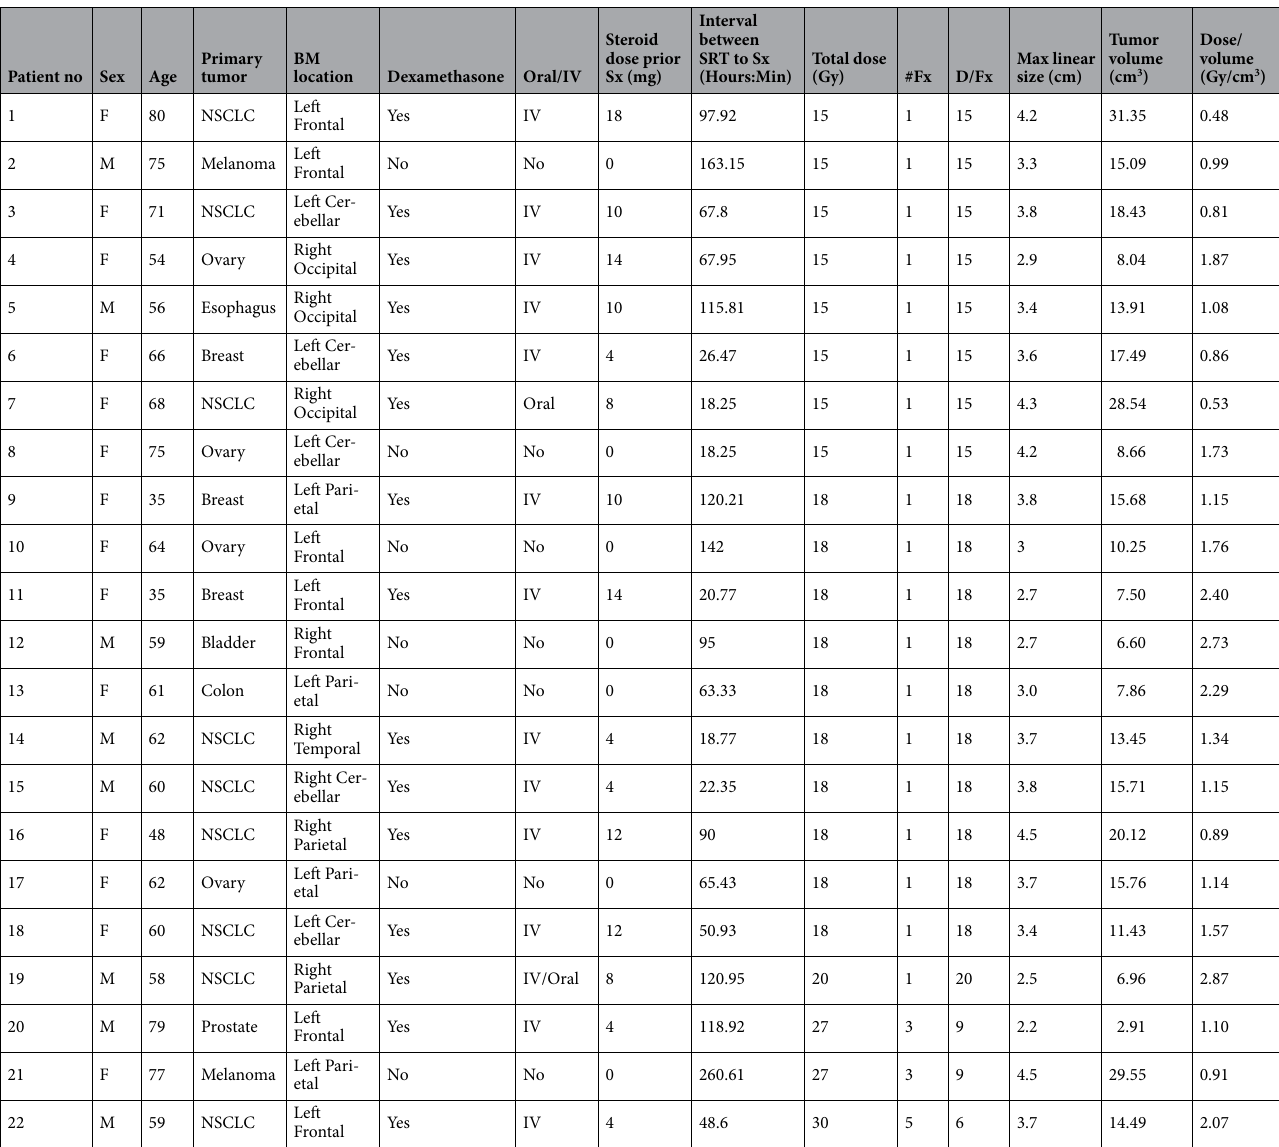
Table 1. Patient and tumor characteristics for those treated with dose-escalated pre-operative stereotactic radiotherapy and surgery. IV intravenous, Sx surgery, SRT stereotactic radiotherapy, #Fx number of fractions, D/Fx dose per fraction, M male, F female, mg milligram, Gy grey, min minute, cm centimeter, cm 3 cubic centimeter, NSCLC non-small cell lung